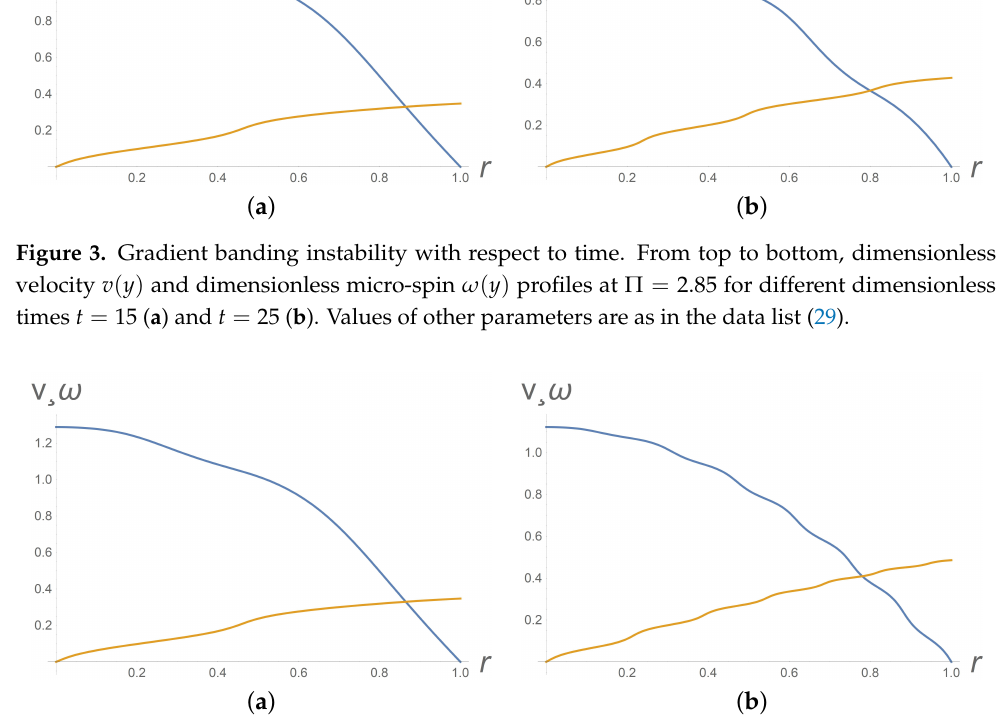
Figure 4. Gradient banding instability with respect to initial particles orientation. From top to bottom, profiles of dimensionless velocity v ( y ) and dimensionless micro-spin ω ( y ) at Π = 2.85 and at t = 15 for initial ϕ 0 ( y ) = 0 ( a ) and ϕ 0 ( y ) = 4 y + 9 y 2 ( b ). Values of other parameters are as in the data list